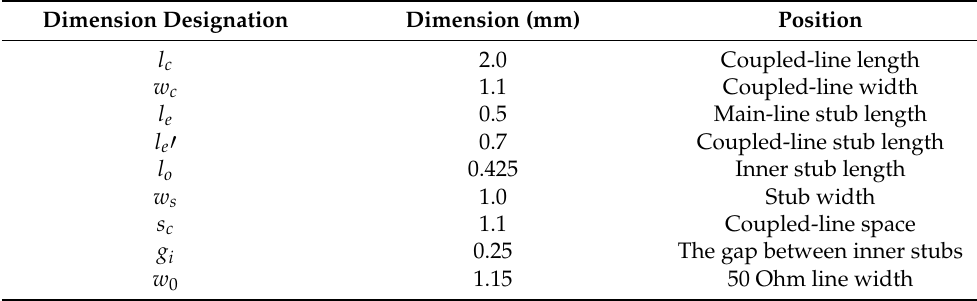
Figure 8. The PCB layout of the coupler: ( a ) final PCB layout (substrate 30 × 30 mm, coupler 4 × 5.5 mm); ( b ) Detailed coupler dimension designation. Table 2. Detailed dimensions of the coupler in Figure 8b.